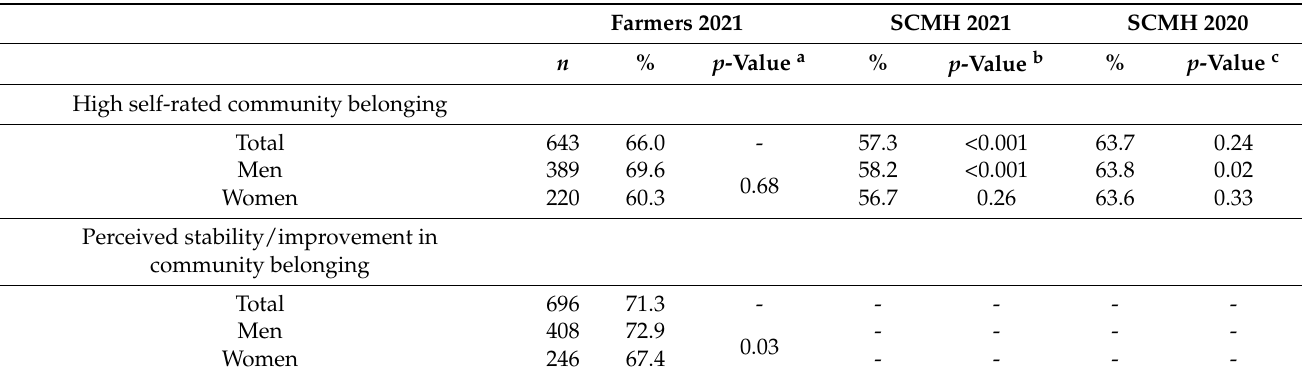
Table 7. Prevalence of high self-rated community belonging and perceived stability/improvement in community belonging since the pandemic began for the overall 2021 sample and by gender in comparison to the Canadian general population from Statistics Canada’s Survey of COVID-19 and Mental Health (SCMH) cycles 1 (Spring 2020) and 2 (Fall